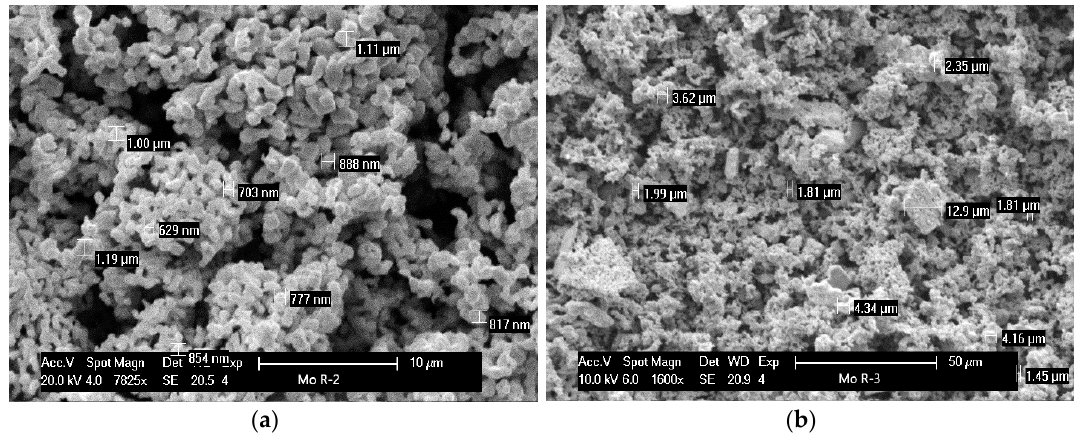
Figure 8. SEM of the products of reduction R-2 ( a ) and R-3.2 ( b ).